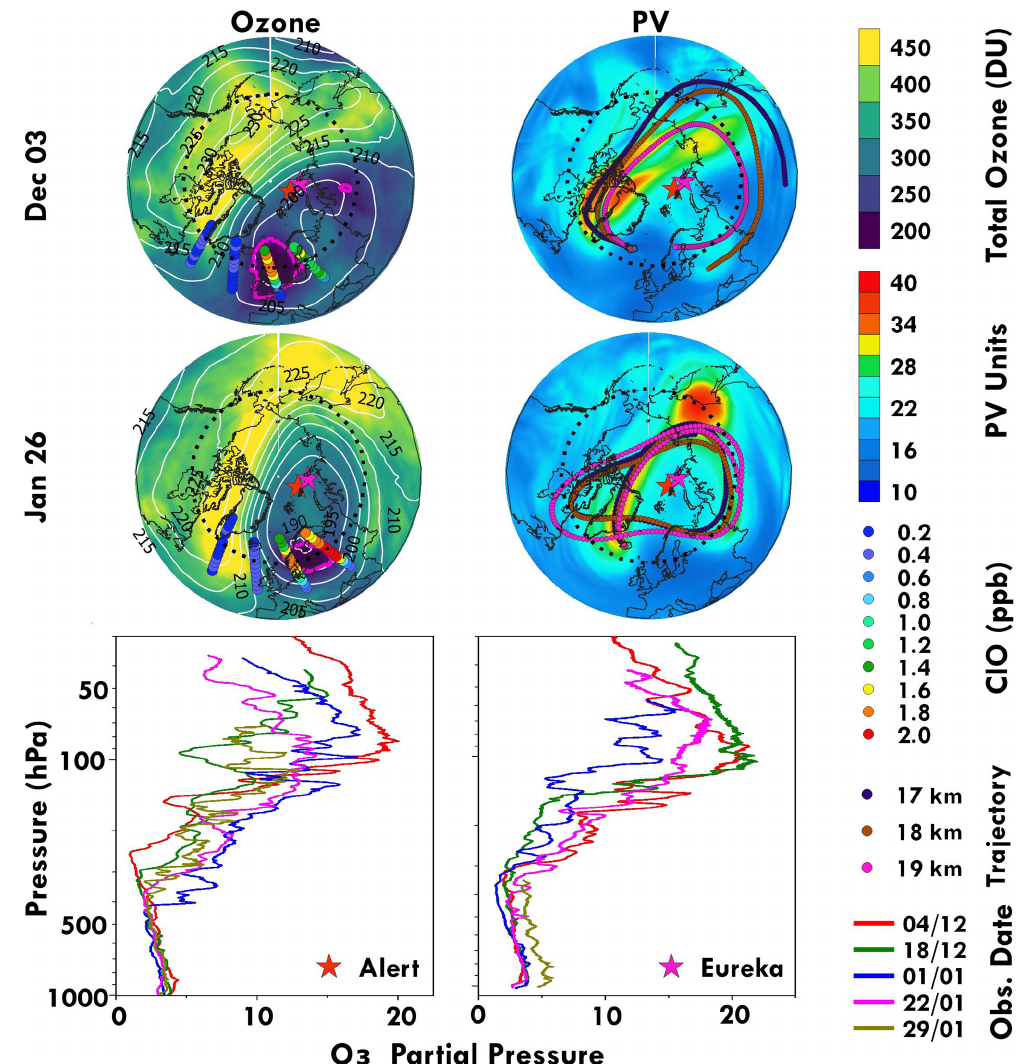
Figure 4. The Arctic ozone mini-holes in December 2019 and January 2020. The total ozone observations by Ozone Monitoring Instrument (OMI) on 3 December 2019 and 26 January 2020. The potential vorticity (PV) maps for the corresponding dates are shown on the right. The air mass trajectories computed using the HYSPLIT model at 17, 18 and 19km are also illustrated in the PV maps. The ozonesonde measurements in December and January at Alert (62.34 ◦ N, 82.49 ◦ W) and Eureka (79.99 ◦ N, 85.90 ◦ W) are illustrated in the bottom panel and are also shown in the maps as red and magenta stars,